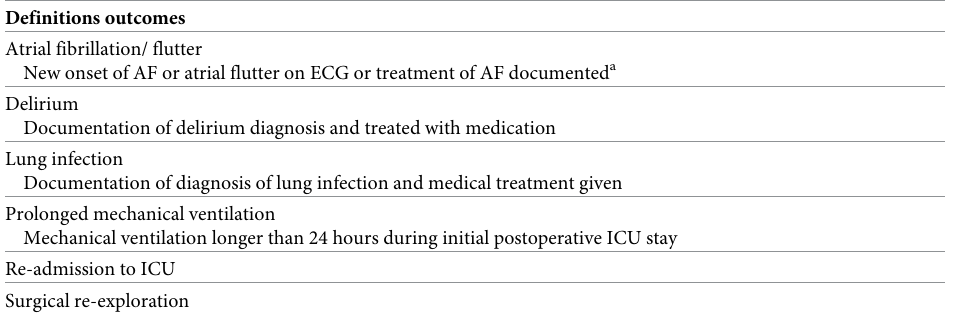
Table 1. Definitions of in-hospital postoperative